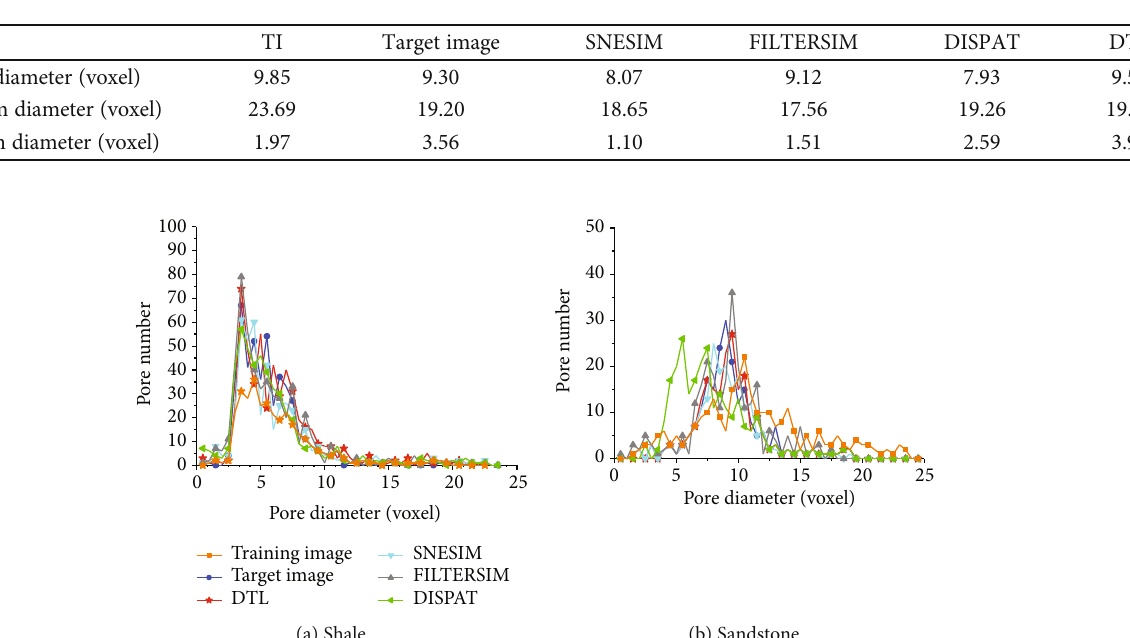
Figure 22: The distributions of pore diameters of the TIs, the target images, and the reconstructed images of DTL, SNESIM, FILTERSIM, and